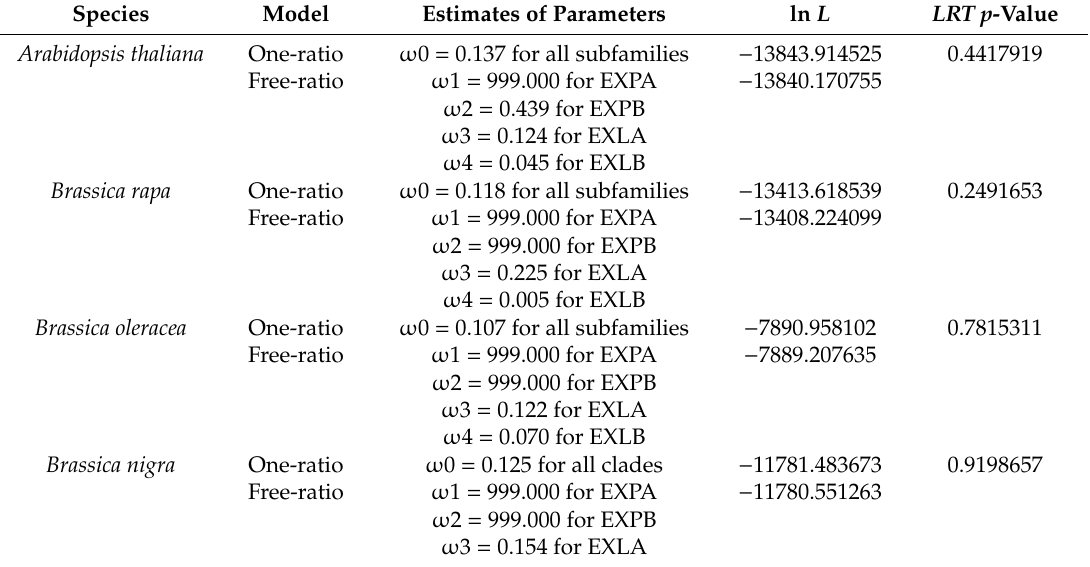
Brassica nigra One-ratio − 11781.483673 0.9198657